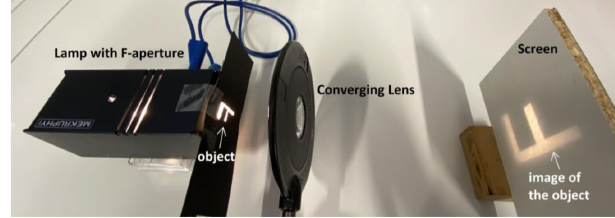
1. An illuminated object being refracted by a lens and projected on a